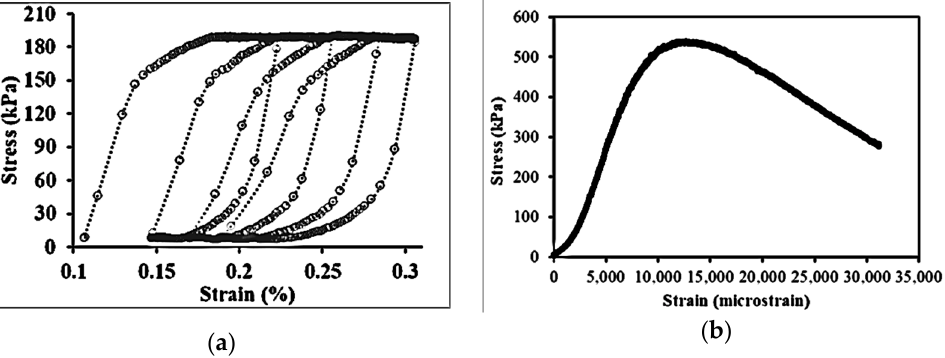
Figure 4. Stress–strain state in compression: ( a ) hysteresis loop under creep-recovery and ( b ) crosshead strain rate test.